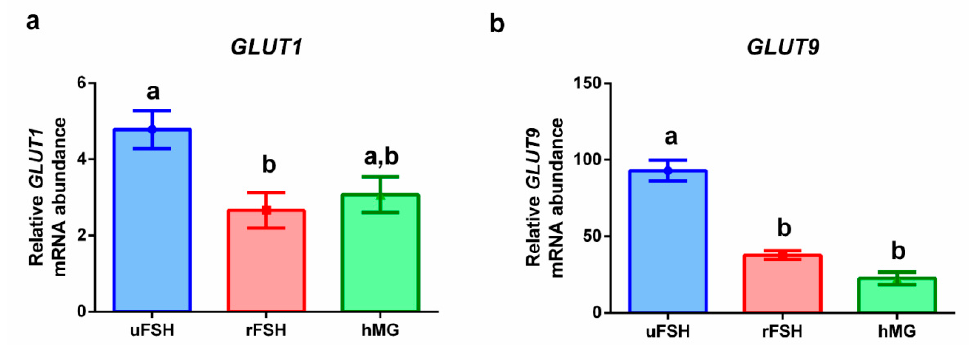
Figure 4. Gene expression profiles: ( a ) GLUT1 : glucose transporter 1 ( SLC2A1 : solute carrier family 2 member 1); ( b ) GLUT9 : glucose transporter 9 ( SLC2A9 : solute carrier family 2 member 9). Results are reported as mean ± standard deviation. Statistical significance was set at p < 0.05 and calculated by ANOVA followed by Tukey’s multiple comparisons test. Different letters above columns indicate statistical differences among groups.